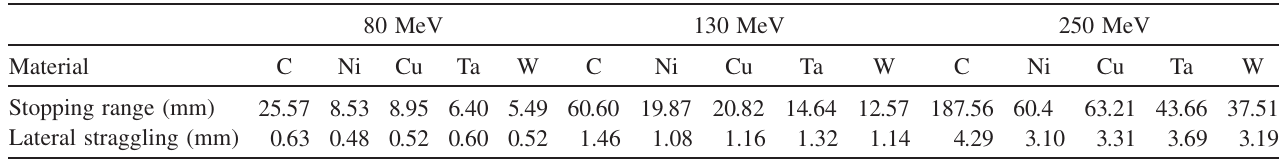
TABLE I. Stopping ranges and lateral stragglings of different materials of proton beam at three different energies.